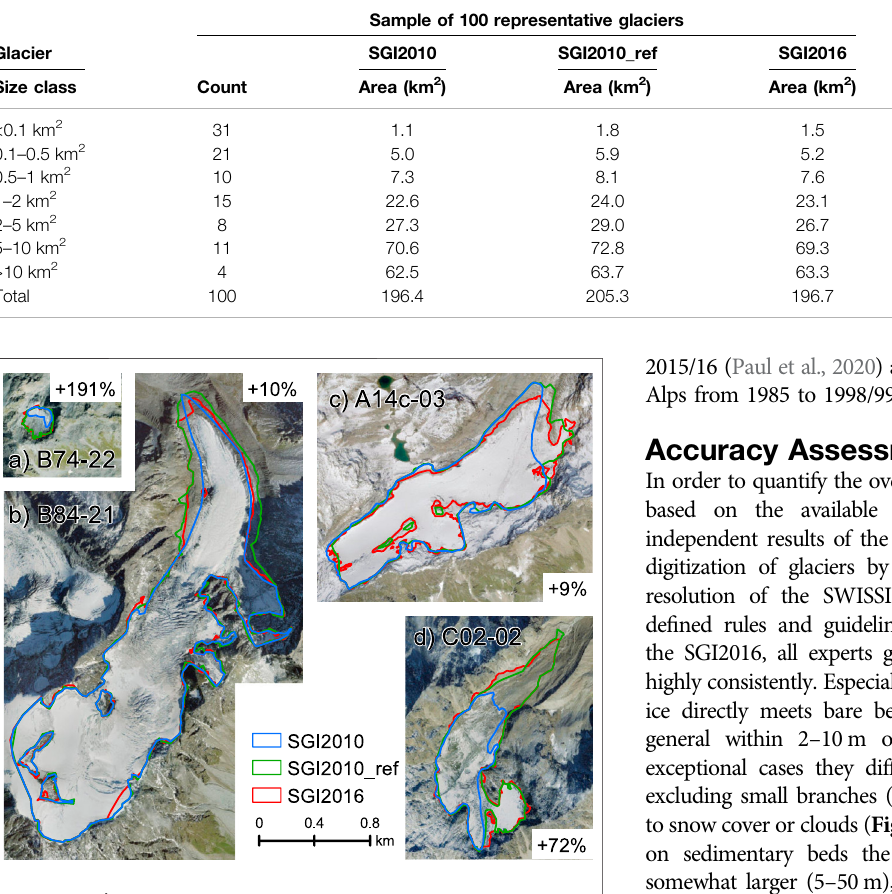
Frontiers in Earth Science |